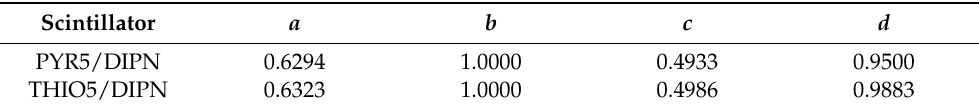
Figure 4. Light output function for all measurements detected using a 1 inch ( a ) PYR5/DIPN scintillator, and ( b ) THIO5/DIPN scintillator. The data points are completed with fit functions for each scintillator. The fit functions are described in Table 1. Table 1. Table of coefficients for the LOF fits for both scintillators. The fit function is: L = aE p − b ( 1 − exp ( − cE d p ))